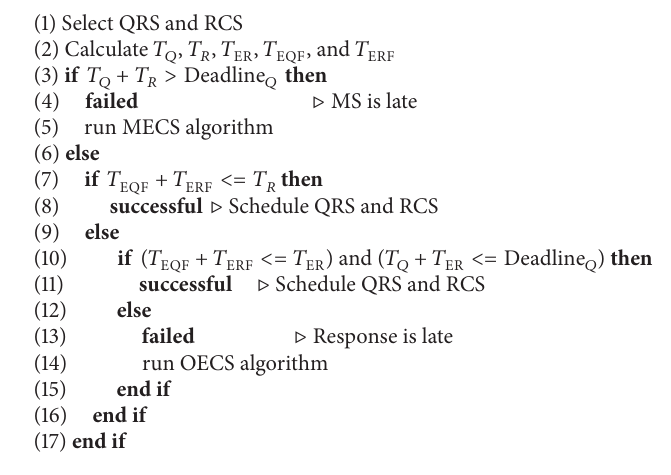
Algorithm 1: Calculate Least Energy Consuming Schedule.